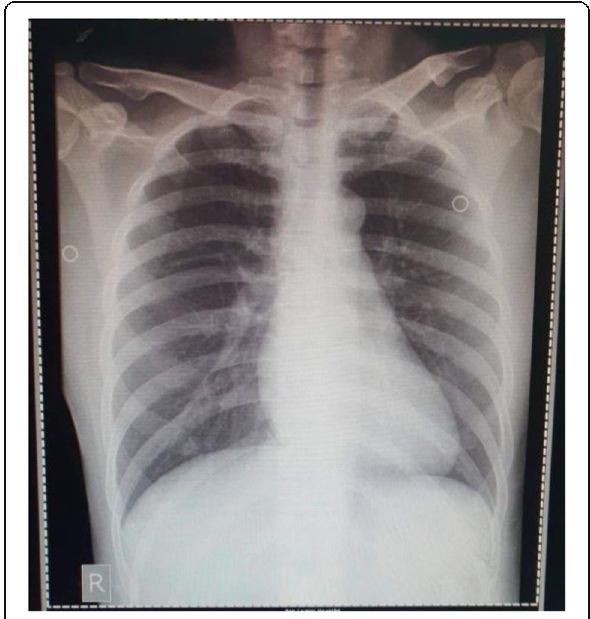
Fig. 3 Posteroanterior chest radiograph of patient 1, 27 January 2020 (illness day 7). Unremarkable